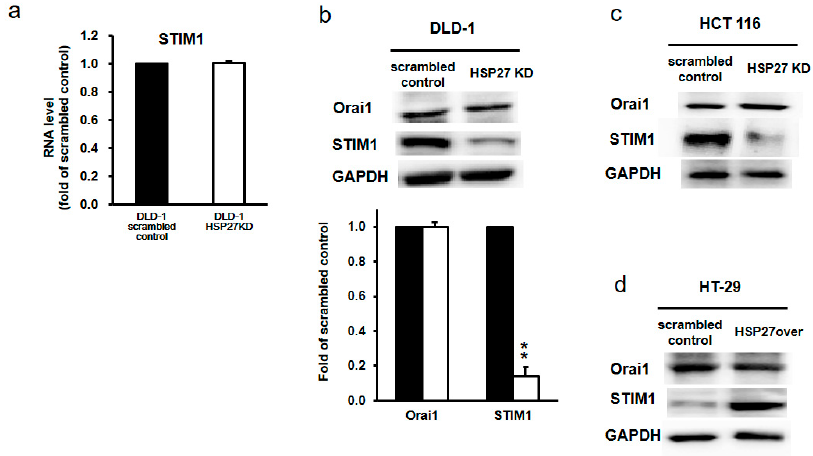
Figure 7. HSP27 increased the STIM1 protein levels in CRC cells. ( a ) QPCR was used to determine the STIM1 mRNA levels, and the levels were normalized to the GAPDH level. ( b , c and d ) Protein extracts prepared from the indicated cell lines were subjected to western blot analysis for STIM1 or Orai1. GAPDH was used as an internal control. Data are representative of three independent